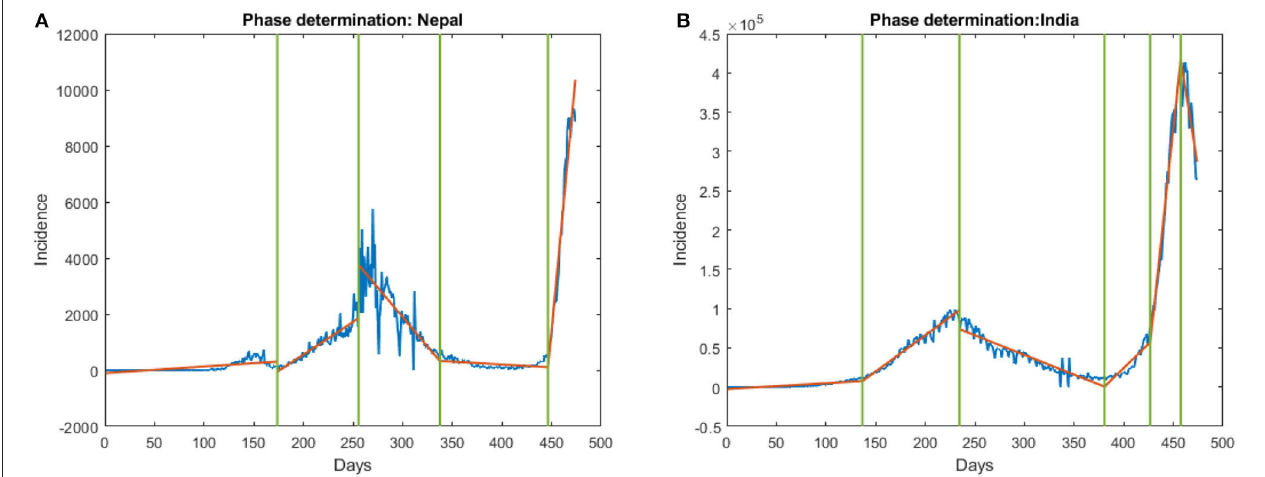
FIGURE 3 | Onset and end of phase in (A) Nepal and (B) India. The first vertical line represents the onset of the first phase and the second represents the onset of the end of the first phase. Similarly, the third line indicates the end of the first